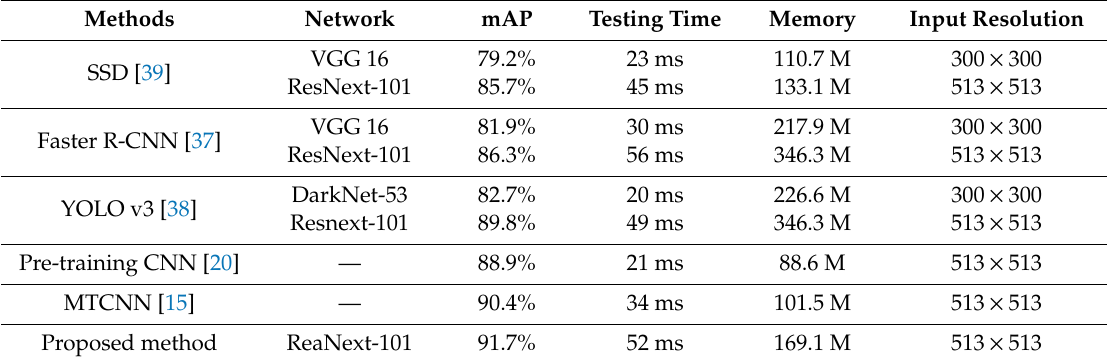
Table 6. Accuracy comparison on CVLD dataset.